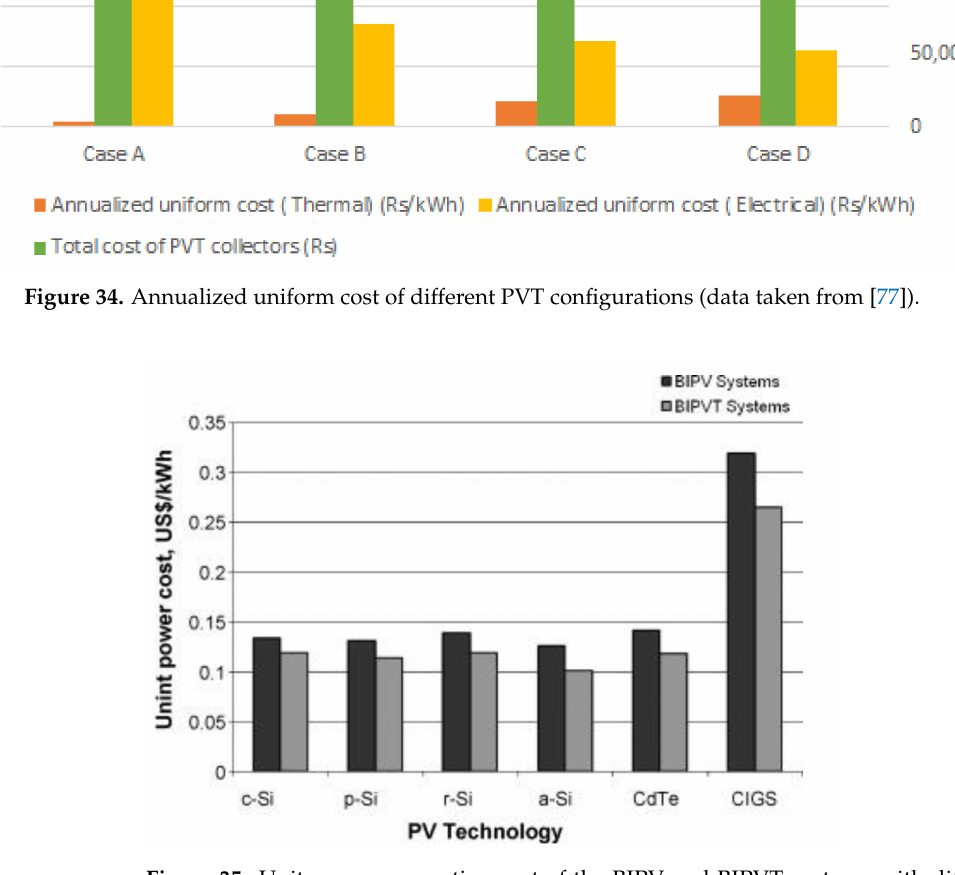
Figure 35. Unit power generation cost of the BIPV and BIPVT systems with different solar cells (reprinted from [18], with permission from